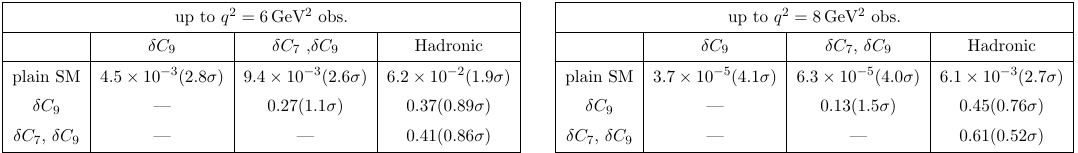
Table 4 . Likelihood ratio p -values and signi(cid:12)cances obtained using Wilks’ theorem for observables up to q 2 = 6 GeV 2 and q 2 = 8 GeV 2 in the left and right table,